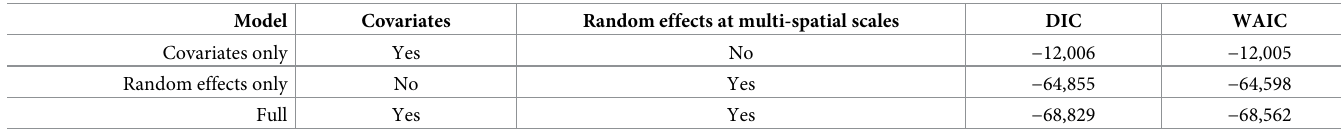
Table 1. Model comparison via DIC and WAIC. Model Covariates Random effects at multi-spatial scales DIC